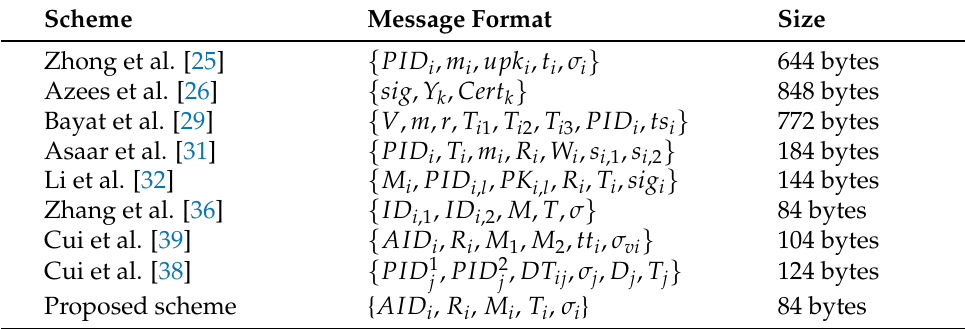
Table 5. Communication cost